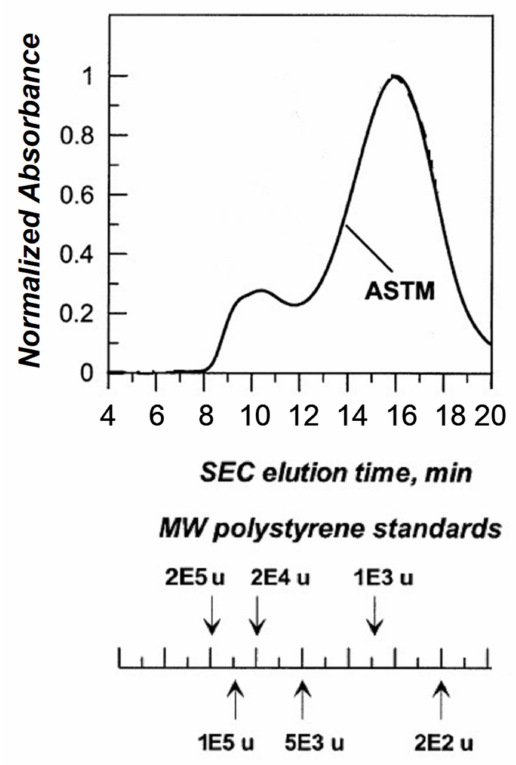
Figure 8. SEC chromatogram of asphaltenes, adapted from